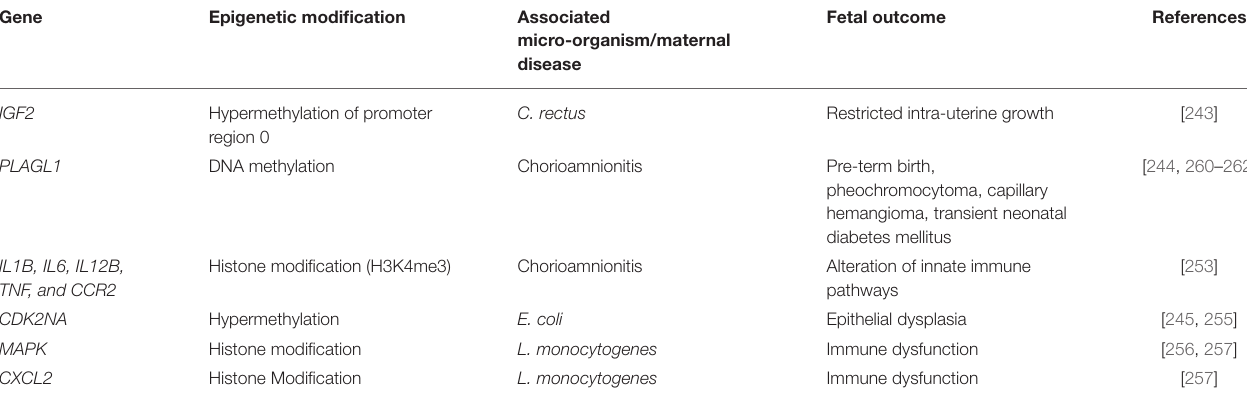
TABLE 1 | Epigenetic modifications on human genes induced by maternal infections and associated fetal adverse